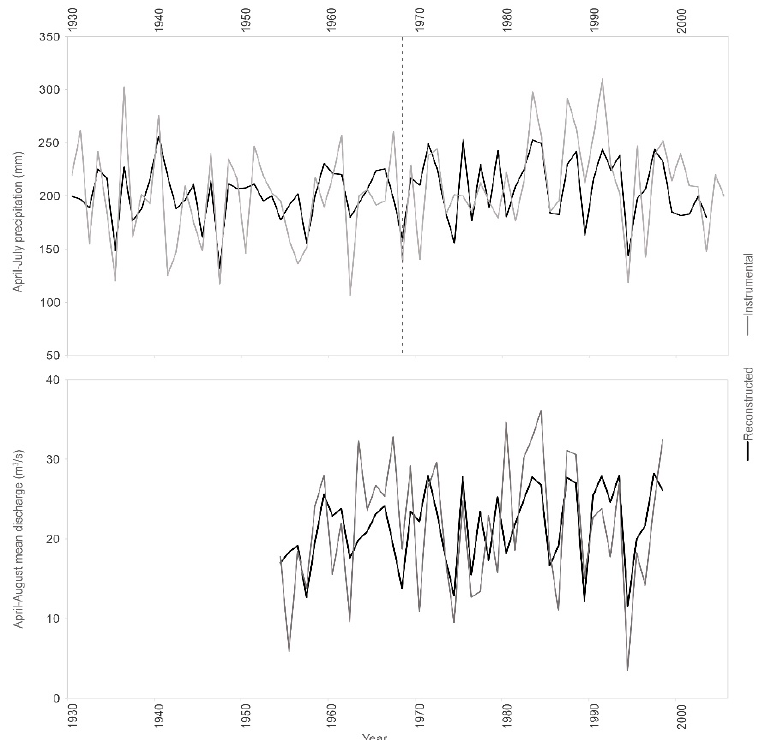
Figure 6. Instrumental and reconstructed April-July total precipitation (mm) (upper) and instrumental and reconstructed mean April–August Gök ı rmak River streamflow (m 3 /s) (lower). Vertical gray dashed line indicates split calibration and verification periods of precipitation reconstruction.